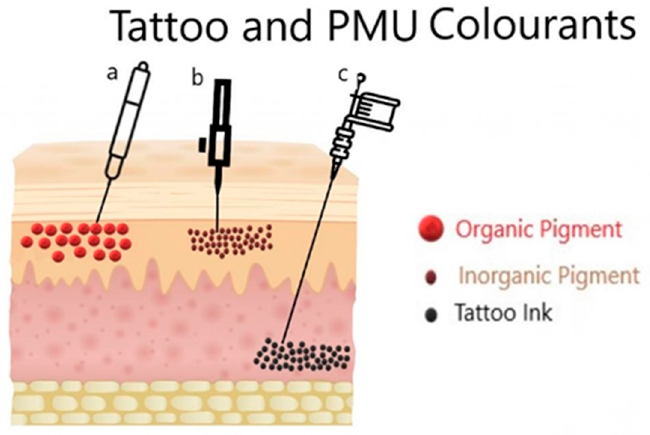
Figure 2. The depth of tattoo and PMU colorants according to organic and inorganic ink and different machine use. Inorganic pigments contain bigger particles of colorants and are placed deeper into the skin. ( a ) Manual PMU pen (microblading), ( b ) PMU machine, ( c ) tattoo machine. Image courtesy of Eleni Andreou.